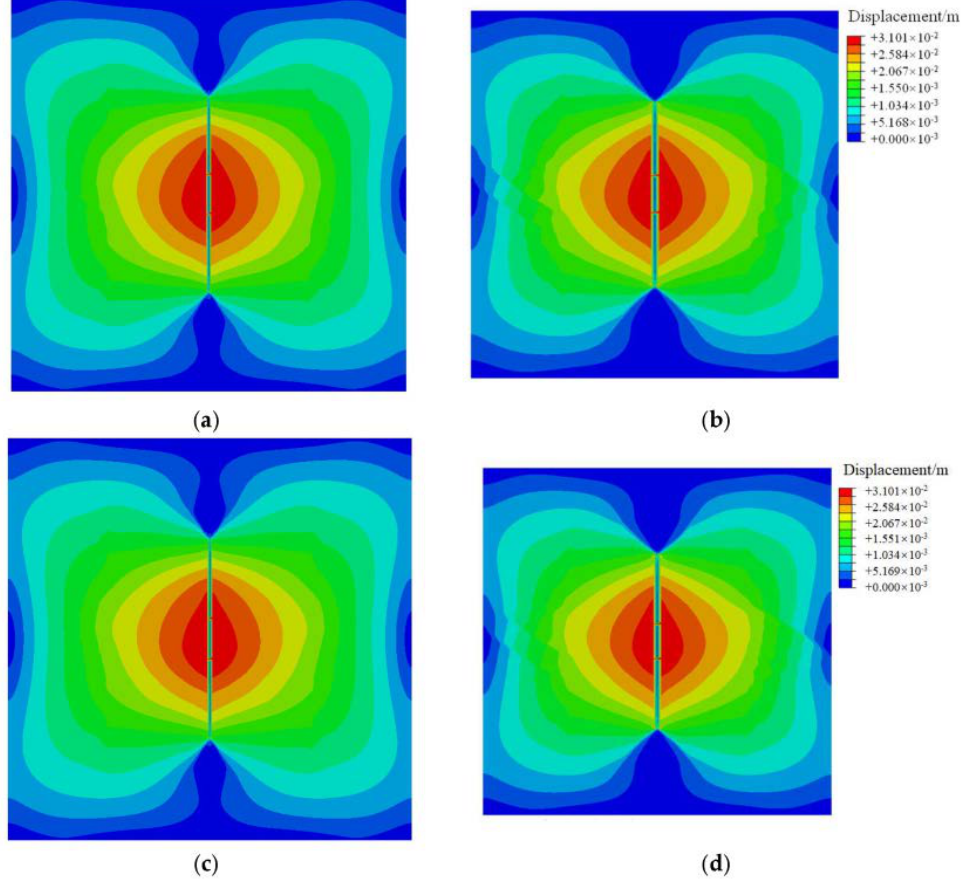
Figure 20. Cloud picture of displacement field under different fracture energies: ( a ) fracture energy of 3000 Pa · m, time t = 55 s; ( b ) fracture energy of 3000 Pa · m, time t = 100 s; ( c ) fracture energy of 4000 Pa · m, time t = 55 s; and ( d ) fracture energy of 4000 Pa · m, time t = 100